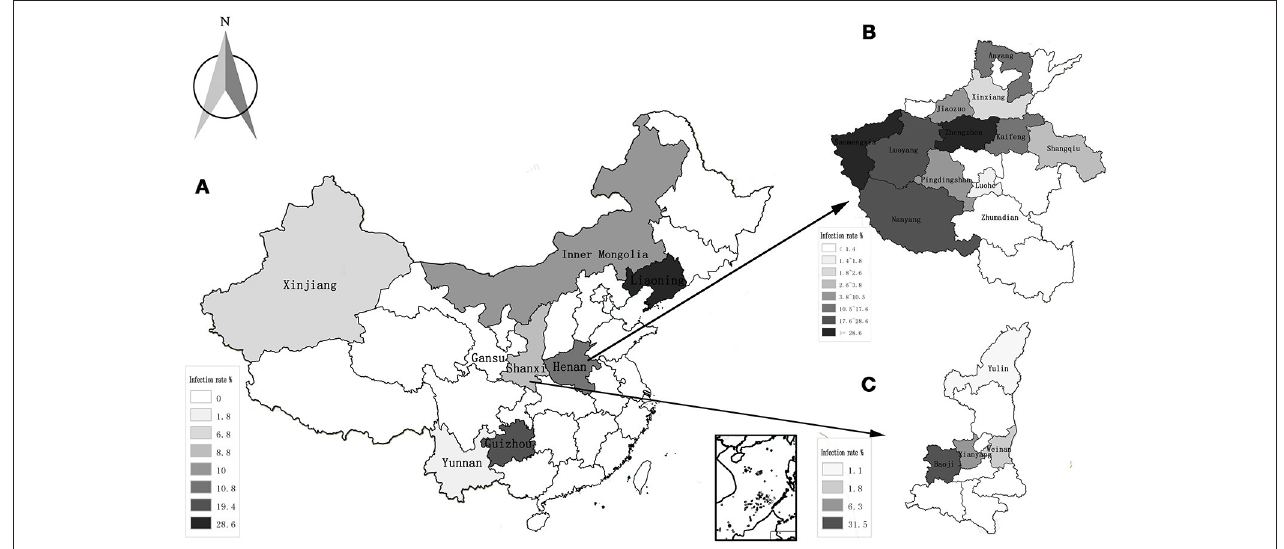
FIGURE 1 | Distribution and infection of A. capra in all the studied regions. (A) The average rate of infection in 8 provinces of China; (B) the rate of infection in 12 countries of Henan province; (C) the rate of infection in 4 countries of Shanxi province.